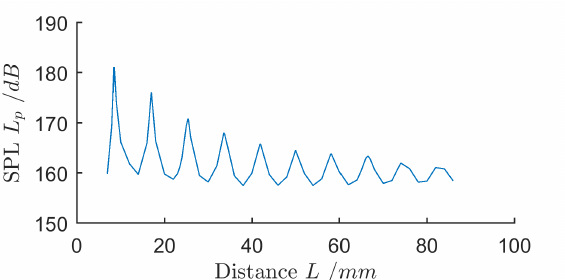
Figure 4. Maximum sound pressure level (SPL) from FE-Model over varying distance between transducer and plain reflector; f = 21.4 kHz; ˆ x = 19 µ m.